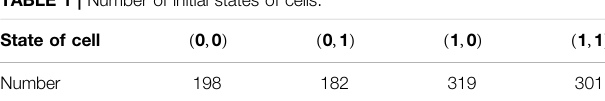
TABLE 1 | Number of initial states of